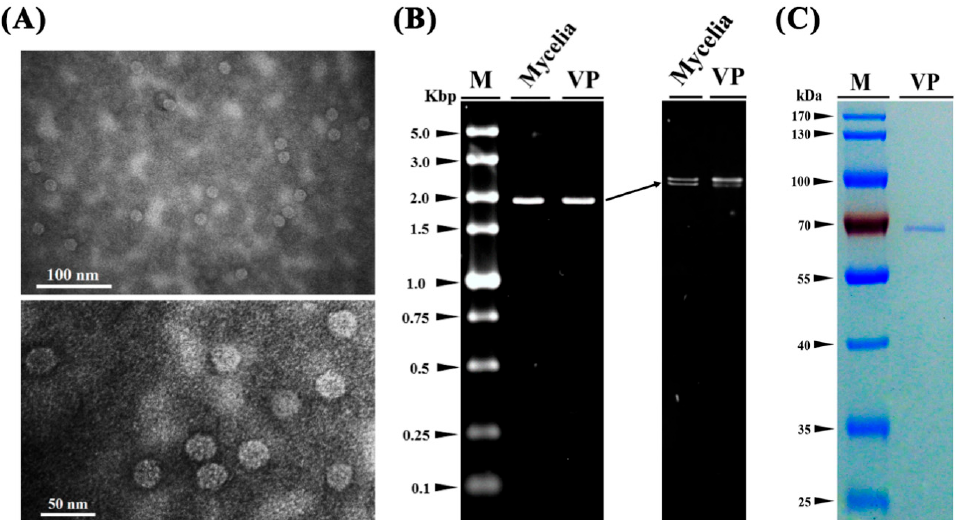
Figure 4. Virus particles isolated from the mycelia of isolate QT5-19 of Botrytis cinerea . ( A ) Two transmission electron microscope (TEM) graphs showing the shape and size of the virus particles of the mycovirus in QT5-19; ( B ) Electrophoregrams showing the two dsRNAs extracted from the virus particles (VP) and the mycelia of QT5-19 (Mycelia). The electrophoregram on the right was created in a 1% agarose gel after 1.5-h electrophoresis under room temperature. The electrophoregram on the left was created in a 0.7% agarose gel after 15-h electrophoresis at 4 °C. M = DL5000 marker (TaKaRa); ( C ) An SDS-PAGE (10%) electrophoregram showing the band of the structural protein (coat protein) extracted from the virus particles of the mycovirus in QT5-19. The gel was stained with Coomassie brilliant blue R-250. M = PageRuler™ Prestained Protein Ladder.